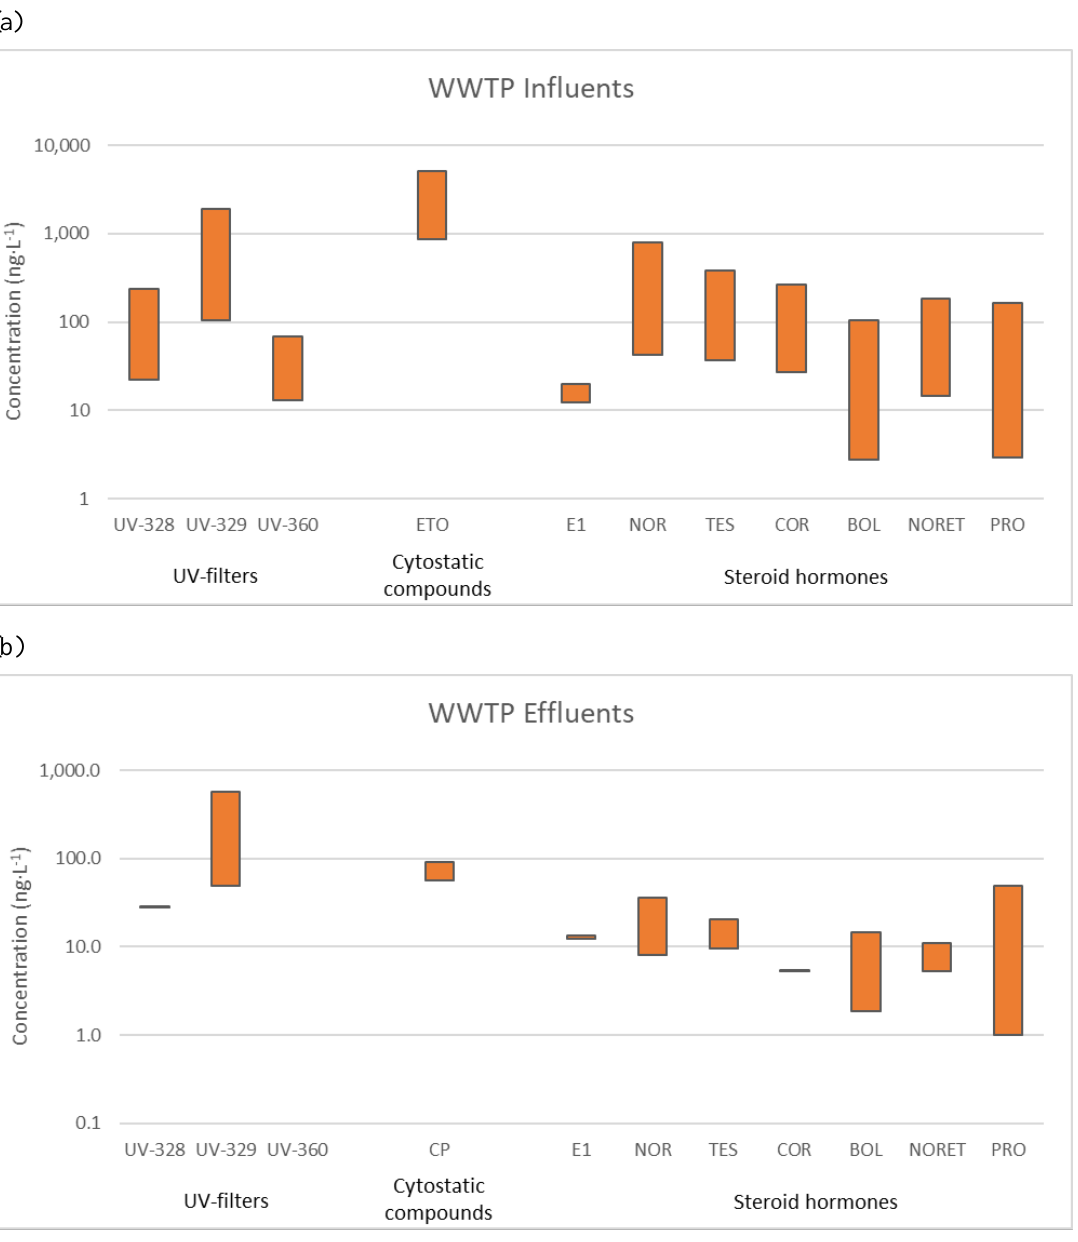
Figure 2. Range of concentrations (ng L − 1 ) for detected emerging pollutants in wastewater from ( a ) influent points and ( b ) effluent points.